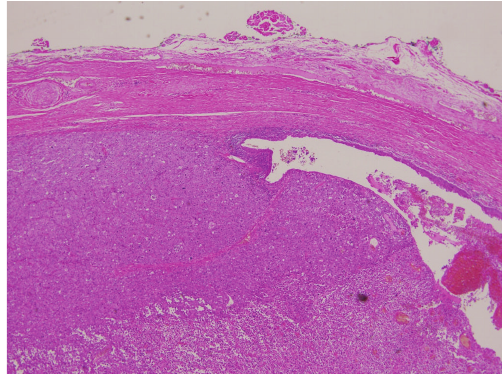
Figure 2: The squamous cell carcinoma developed within the epidermal cyst. (H and E ×40 ).